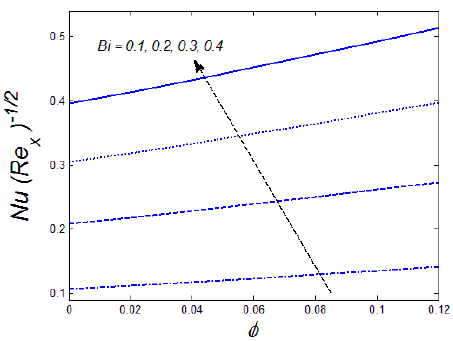
Figure 15. Upshot of Bi and on φ Nusselt number − 1/2 NuRe